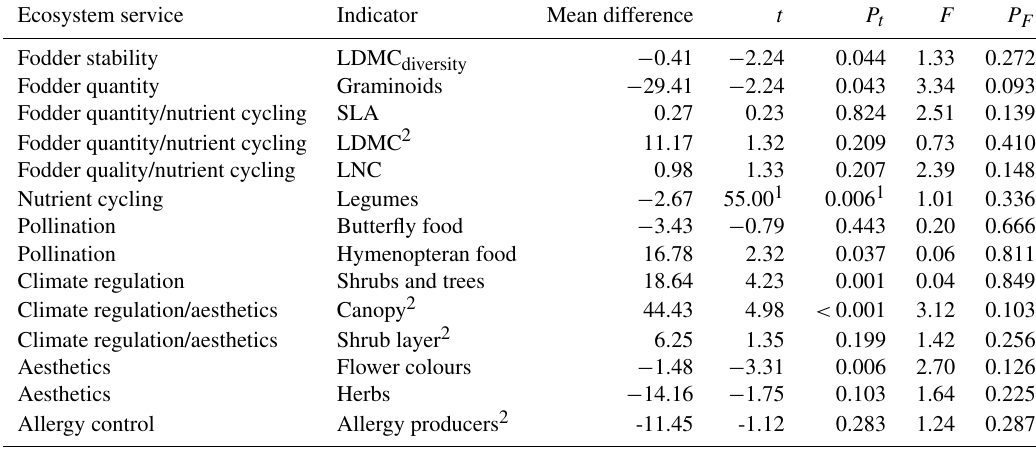
Table 2. Effect of abandonment on ecosystem service (ES) indicators. Mean differences between extensively managed and abandoned semi- natural grasslands, test statistics of the difference between the two land use classes ( t ), significance level of the t ( P t ), test statistics of the differences along time since abandonment ( F ), and significance level of the F ( P F ). t and P t are based on paired t tests or Wilcoxon signed rank test 1 . F and P F are based on linear